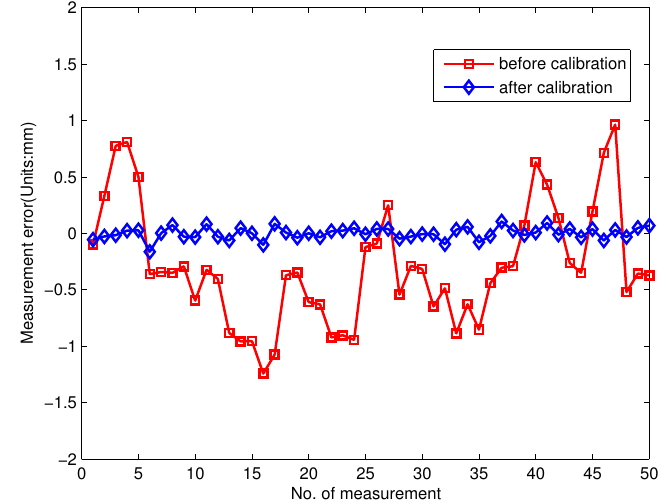
Figure 8. Measurement residual errors of length gauge using PACMM before and after